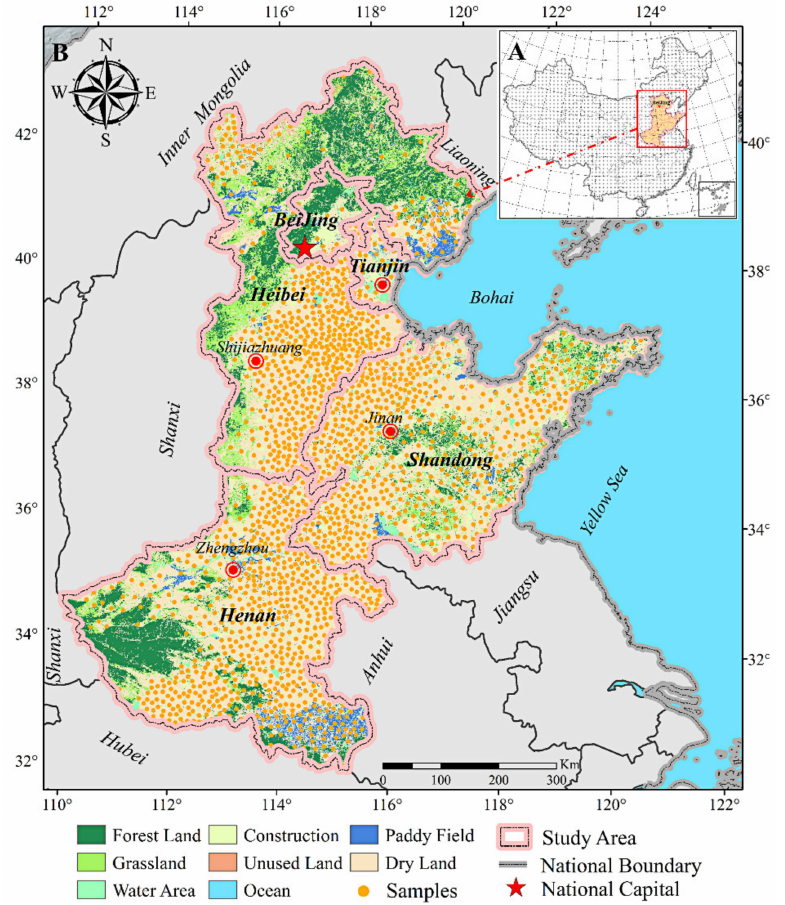
Figure 1. Location and scope of the study area. ( A ) Location of the study area within China; ( B ) land-use map showing sampling points within the areas of cultivated